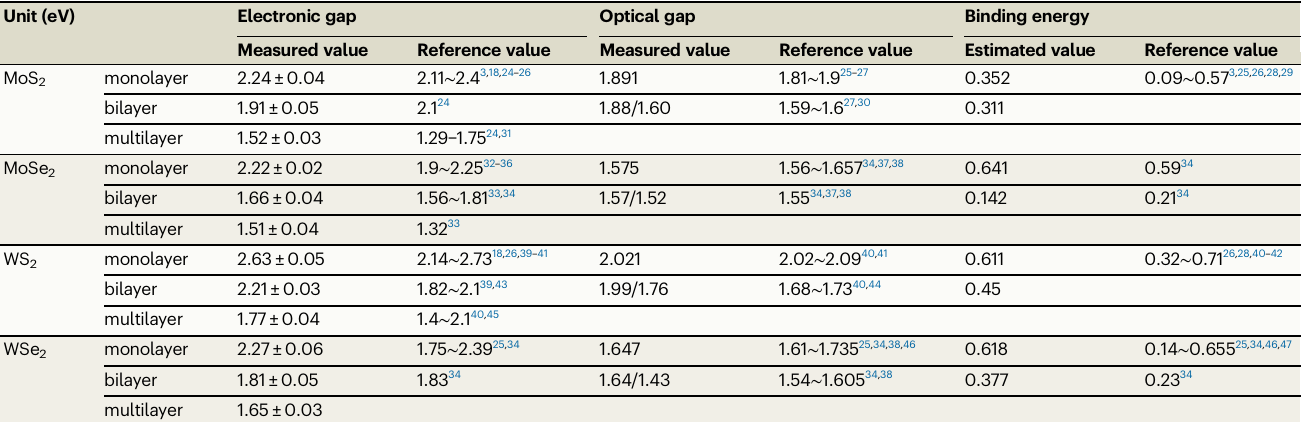
Table 1 | The measured electronic band gap, the optical band gap (direct/indirect for bilayer sample) by photoluminescence spectroscopy, and the estimated exciton binding energy of four representative common TMDCs of different